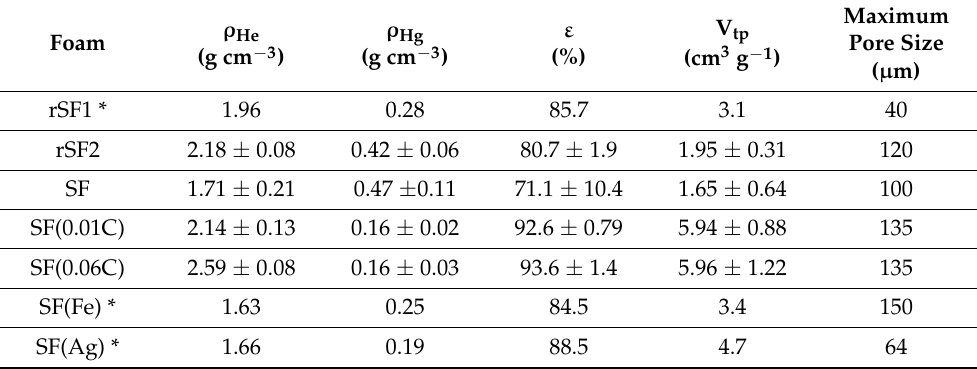
Table 3. True density ( ρ He ), apparent density ( ρ Hg ), open porosity ( ε ), total pore volume (V tp ) and maximum pore size of the sucrose